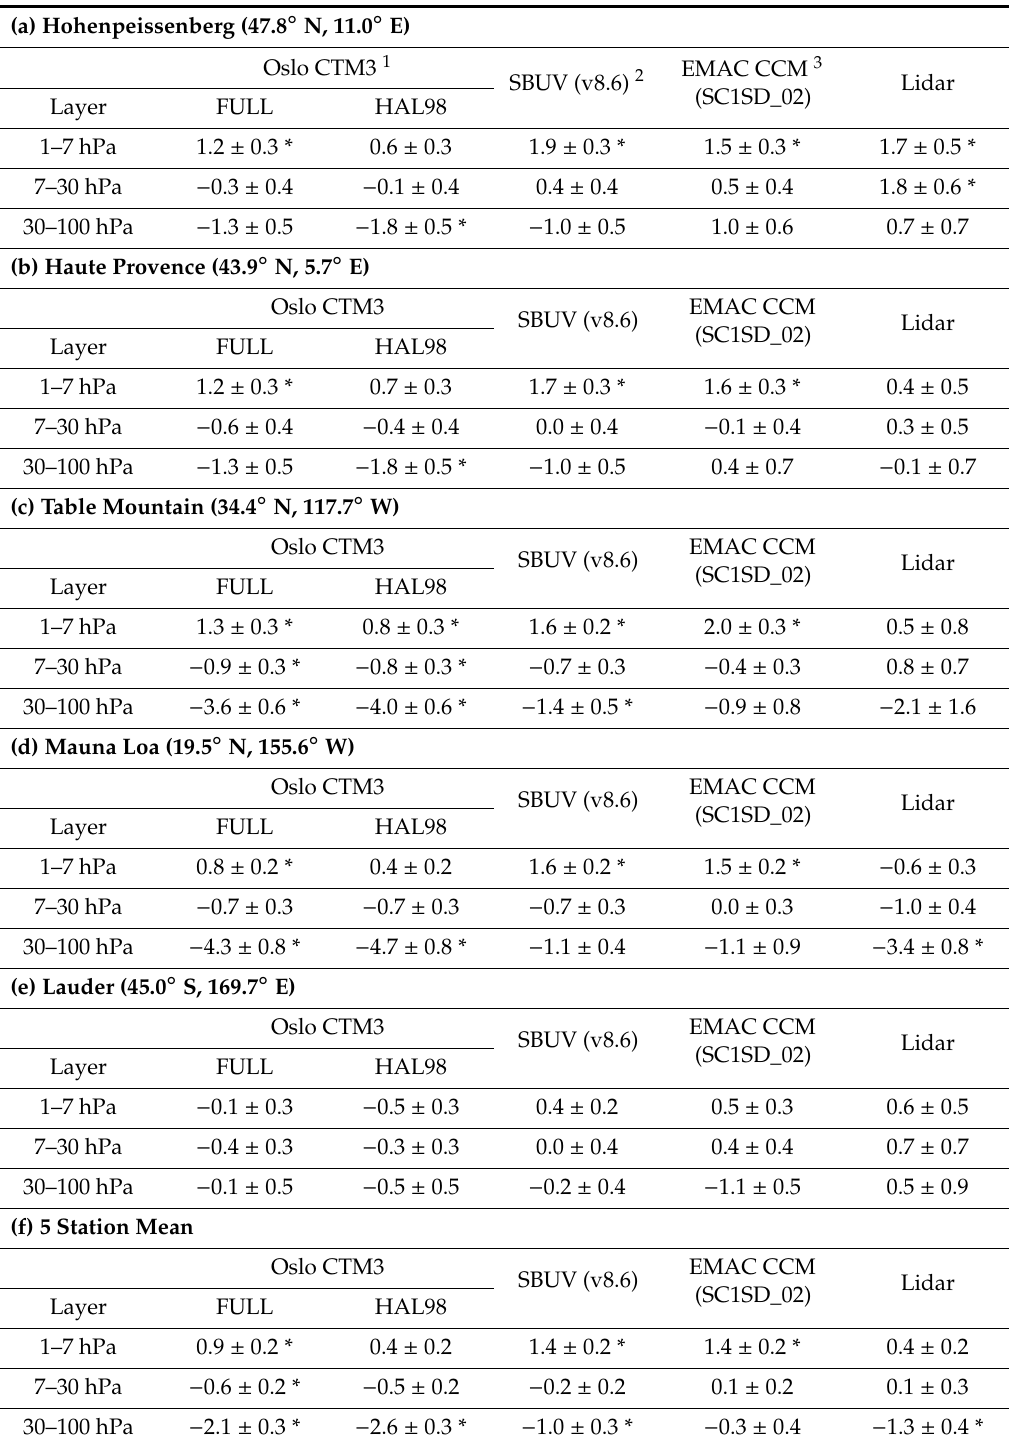
Table 2. Estimated trends (% / decade) in the vertical distribution of ozone for the period of 1998–2016 from observations and model simulations at (a) Hohenpeissenberg, (b) Haute Provence, (c) Table Mountain, (d) Mauna Loa, (e) Lauder and (f) 5 station mean, after removing the seasonal and known natural variability. FULL refers to the main simulation; HAL98 refers to the simulation with fixed halogens at 1998 levels. For lidars, the upper stratospheric layers are confined between 3 and 7 hPa. Asterisks denote statistical significance at the 99% confidence